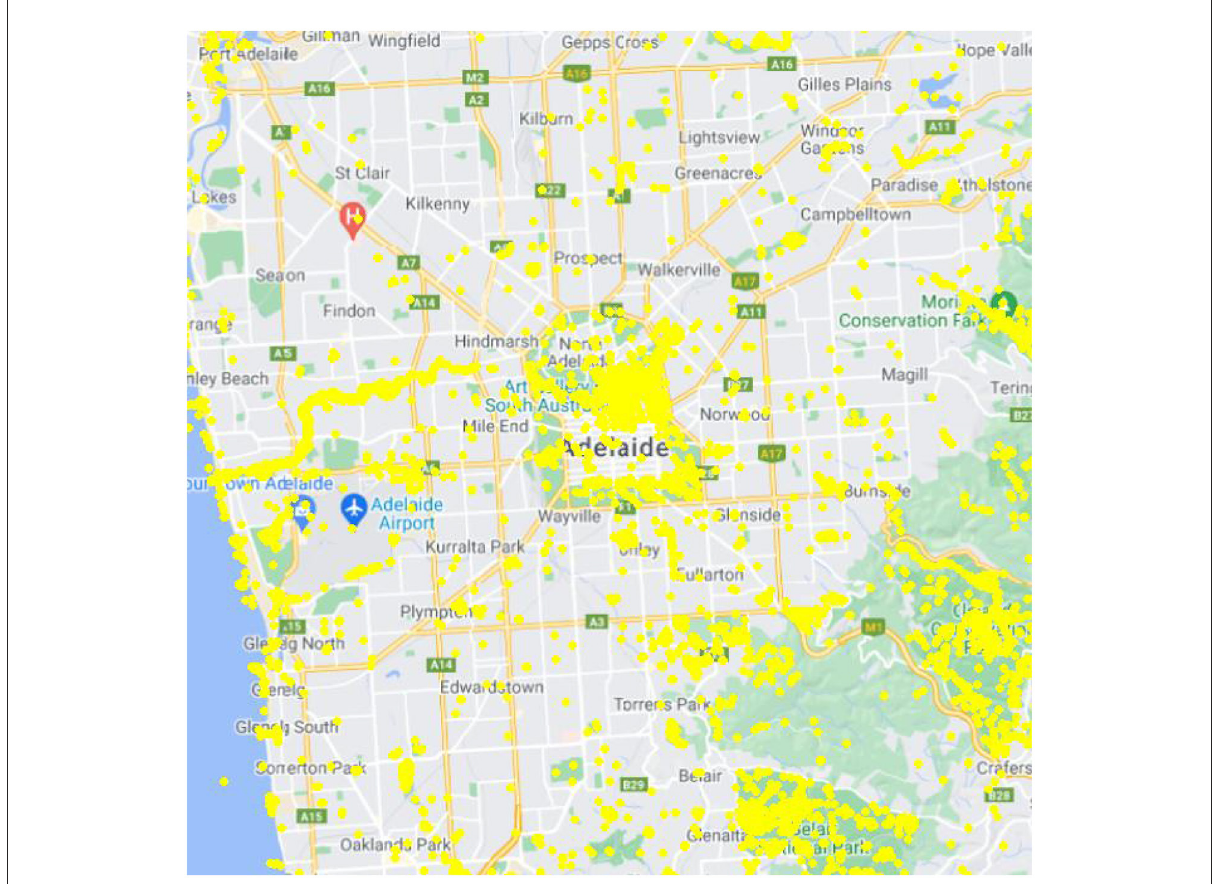
FIGURE1 Distribution of citizen observations of birds centered on the city of Adelaide that were uploaded to the Atlas of Living Australia for the period